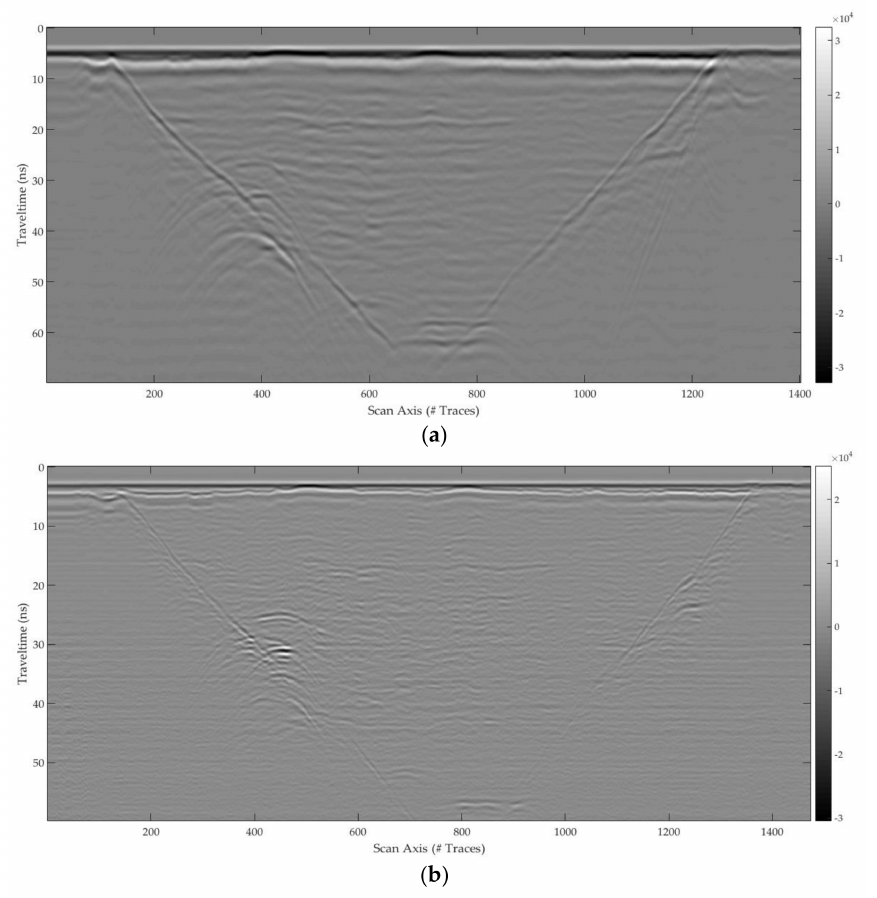
Figure 29. Profiles recorded on acquisition line 1 of the Gneiss 14/20 gravel region by using GPR 1 and antennas operating at: ( a ) 400 MHz; ( b ) 900